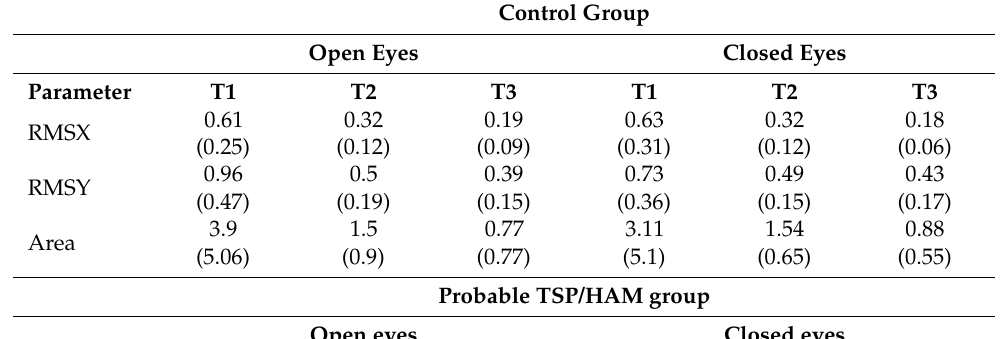
Table 4. Mean (standard deviation) of the global parameters measured in the time